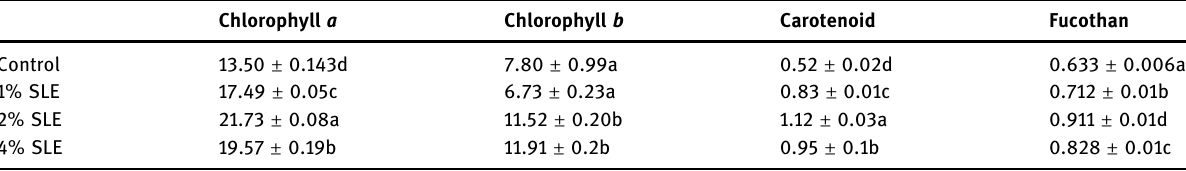
Table 2: E ff ect of di ff erent concentrations of 1%, 2%, and 4% SLE on pigment contents ( mg ‧ g FW − 1 ) T. aestivum